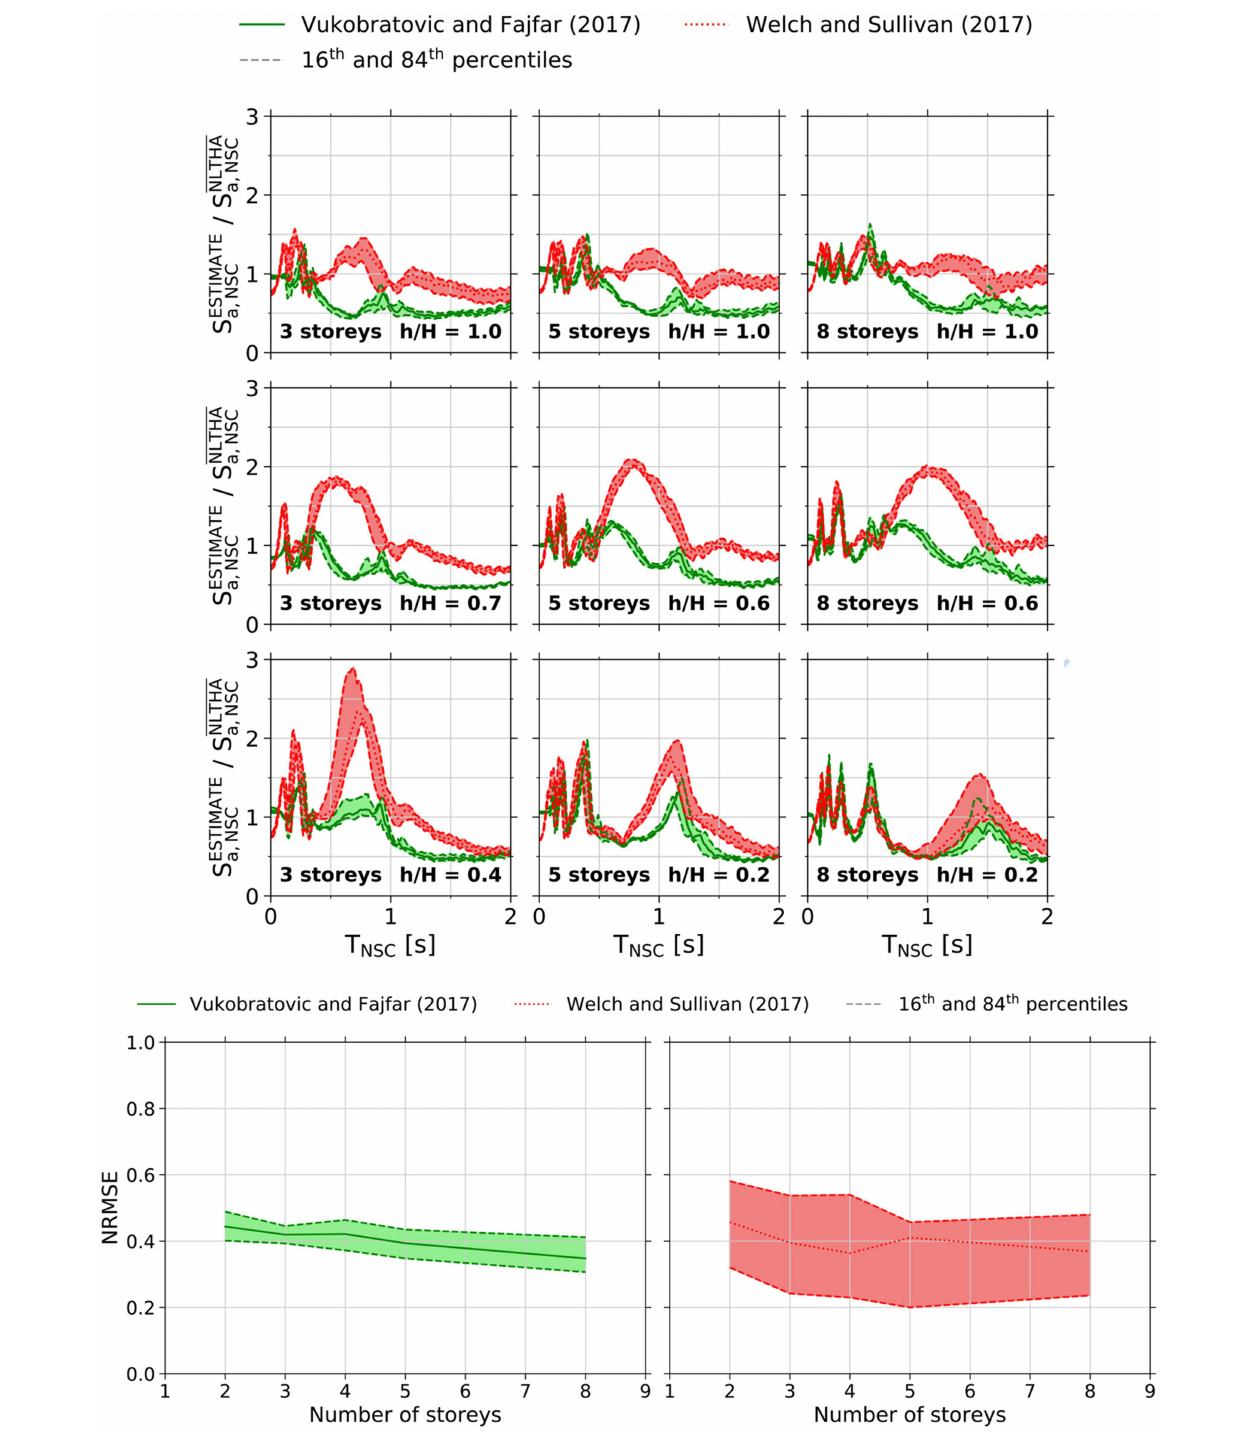
FIGURE 14 | Accuracy of FRS estimation procedures with targeted inelastic ductility demands ( µ = 2).